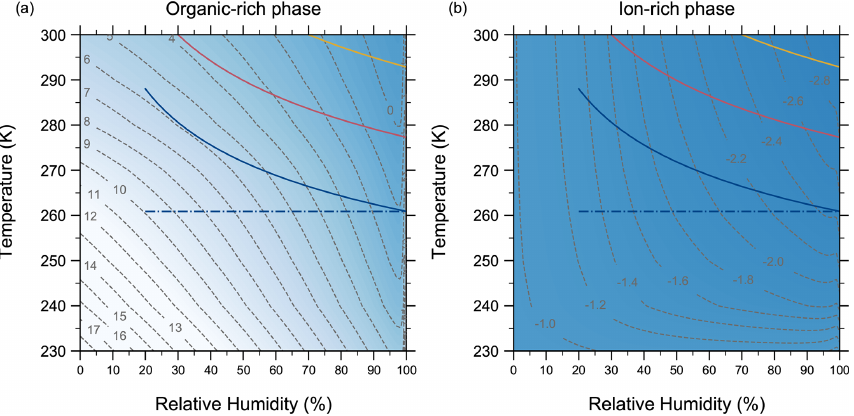
Figure 13. Viscosity predictions for coexisting phases in internally mixed aqueous α -pinene SOA + ammonium sulfate particles with an overall OIR of 1. Dashed curves are contours of log 10 ( η/ [ Pas ] ). The three solid-colored curves represent idealized adiabatic ascent of an air parcel for different initial conditions at the surface. The prescribed initial conditions are T = 288K, RH = 20% (blue); T = 300K, RH = 30% (pink); and T = 300K, RH = 70% (yellow). The dash–dotted blue horizontal line shows the range of RH that could be experienced by particles if they survive cloud processing and stay at the same height, while RH may change. The aquelec mixing model is used to calculate the viscosity of organic–inorganic